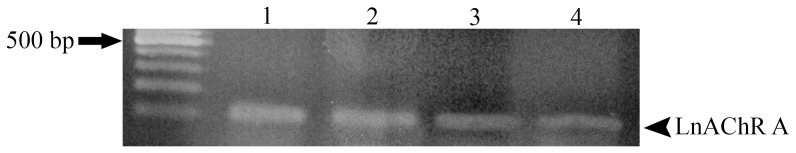
PCR products of LnAChR A subunit expressed in different tissues of snail.Left - DNA ladder, lane 1 - Lymnaea CNS, lane 2 - Helix CNS, lane 3 - Helix columellar muscle, lane 4 - Helix flexor muscle, loaded on ethidium bromide stained gel. In all lanes the calculated weight of the amplified product was ∼120 bp. DNA ladder lane shows bands at 100 bp increments. The template cDNS in the following amounts were added: 1 µl CNS cDNS, 2 µl CM cDNS and 4 µl FM cDNS in order to maintain the same volume for the PCR reaction. Accordingly, the amount of Master Mix was decreased proportionately.